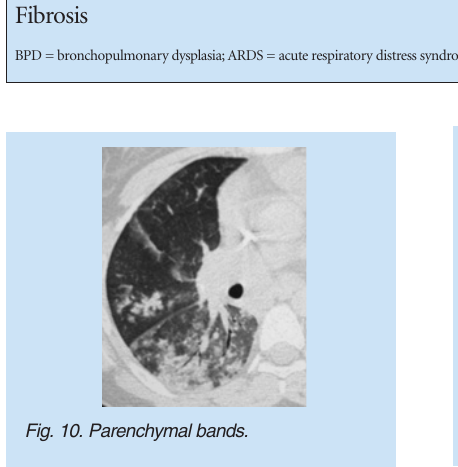
Fig.12a. Bronchiectasis.